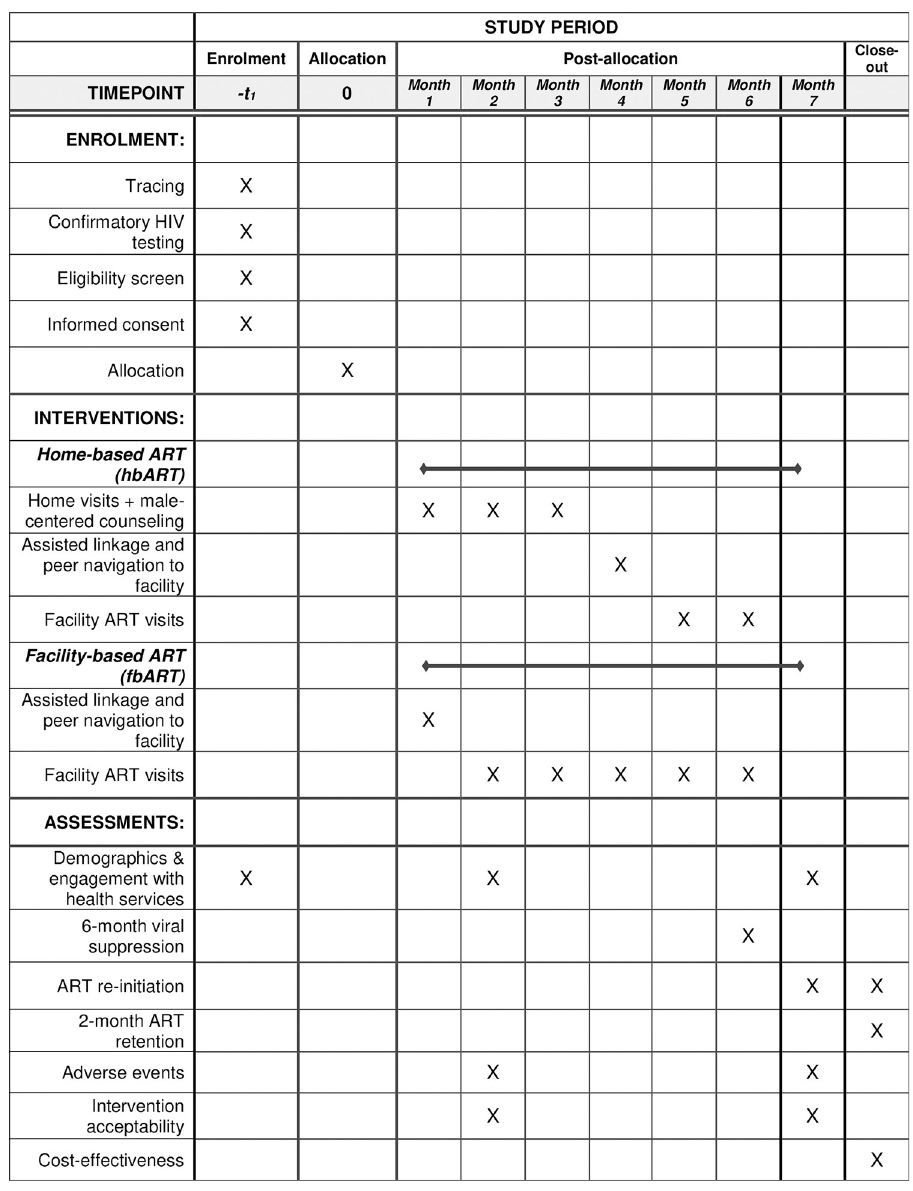
Fig 1. Schedule of enrolment, interventions, and